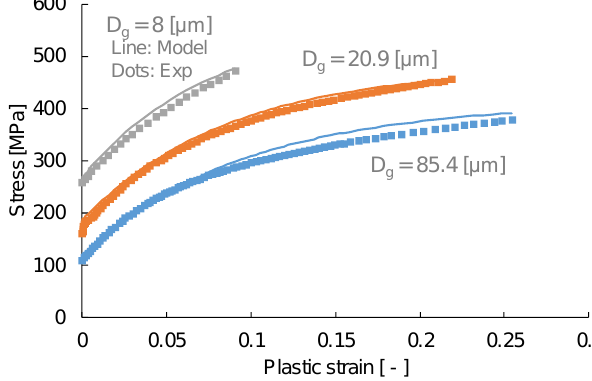
Figure 11. Results of stress–strain curve prediction (Martensitic steels) for several values of: ( a ) D g ; and ( b ) X c .